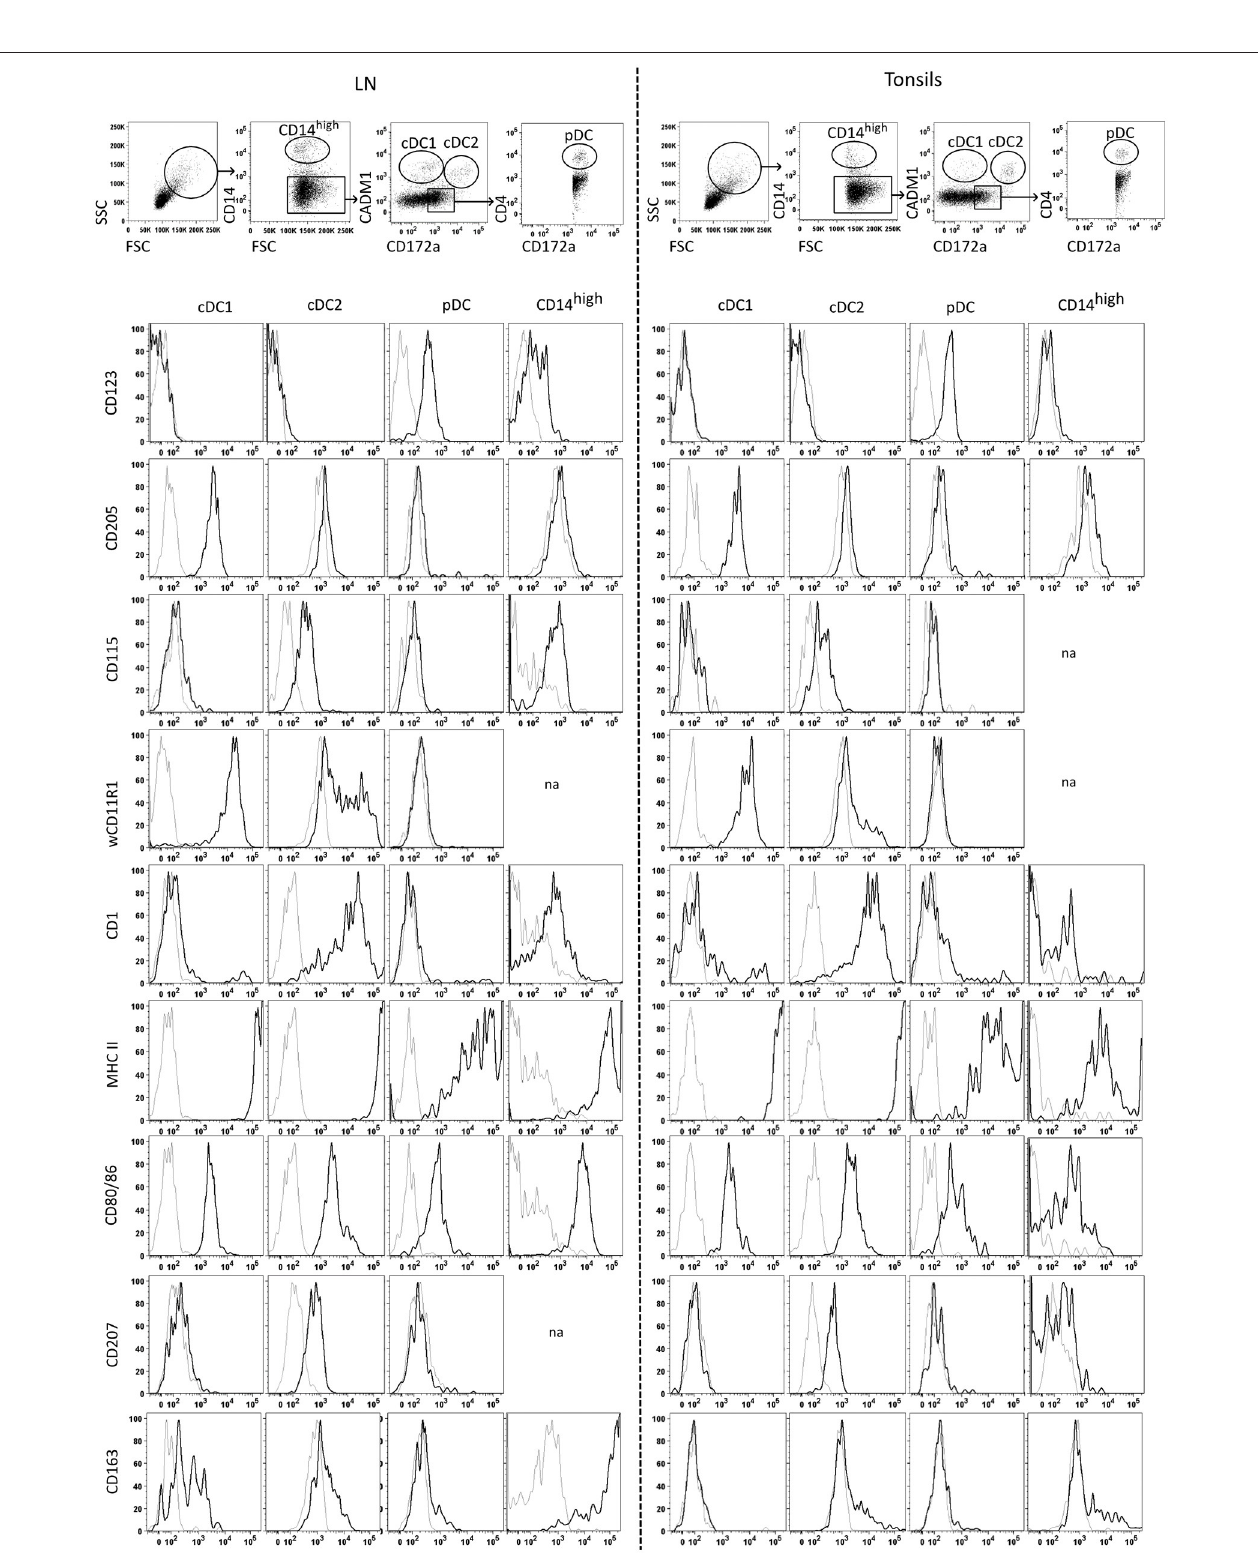
FIGURE 4 | Identification and phenotyping of tonsil and mandibular lymph node mononuclear phagocytes isolated from tonsils and lymph nodes. The top panel shows the gating strategy following multicolor FCM staining using antibodies against CD14, CD172a, CADM1, and CD4. After excluding doublets, cells high in